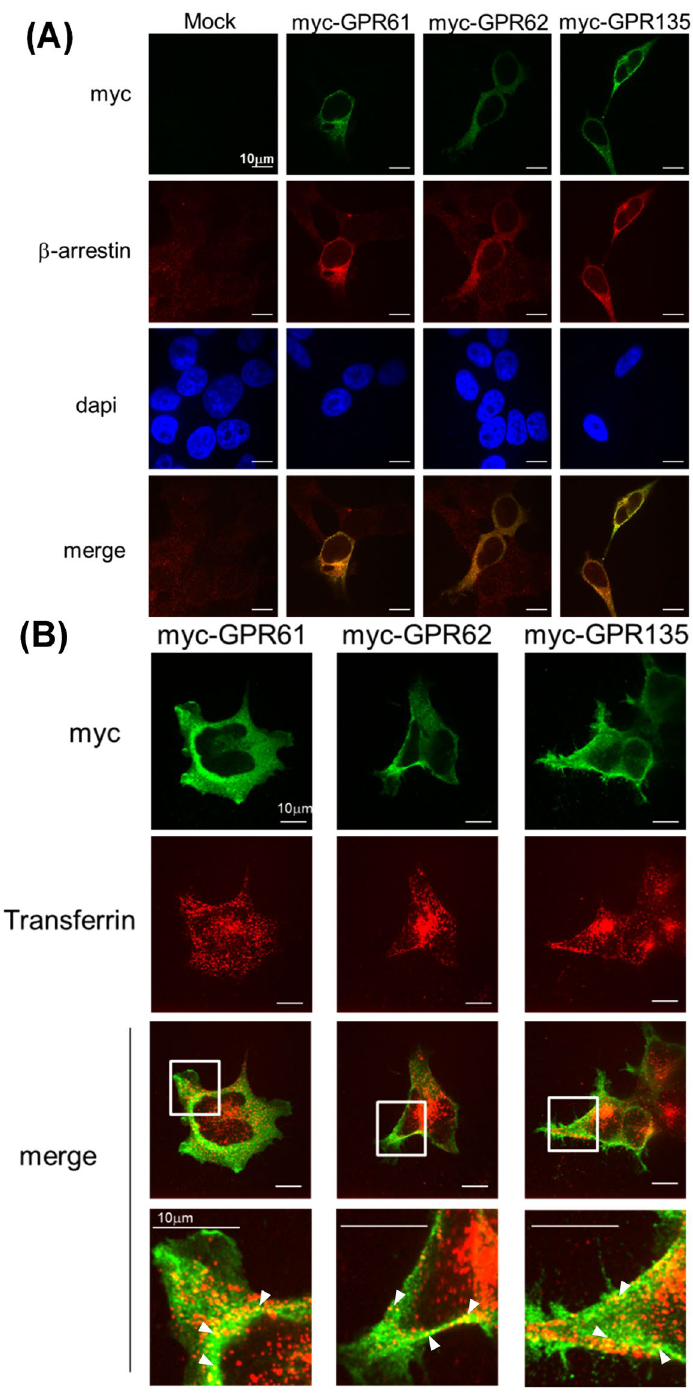
Figure 4. Subcellular localization of myc-GPR61, myc-GPR62, myc-GPR135. ( A , B ) Myc-tagged GPR61, GPR62 or GPR135 were expressed in HEK-arrestin2-EA cells. ( A ) The subcellular localization of GPRs and ß-arrestins was detected in permeabilized cells by confocal microscopy with anti-myc and anti-ß-arrestin antibodies. ( B ) Cells were incubated with Transferrin-Alexa555 (5 μ g/ml for 30 minuites in 37 °C) to label endosomal compartments and permeabilized. GPRs were detected with anti-myc antibodies and colocalization with internalized Transferrin-Alexa555 was monitored by confocal fluorescence